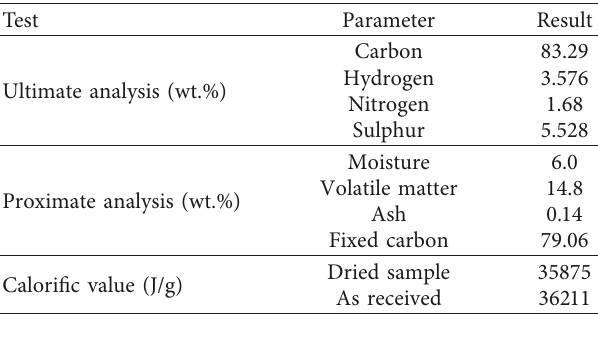
Table 3: Ultimate, proximate, and calorific value analysis of petcoke.